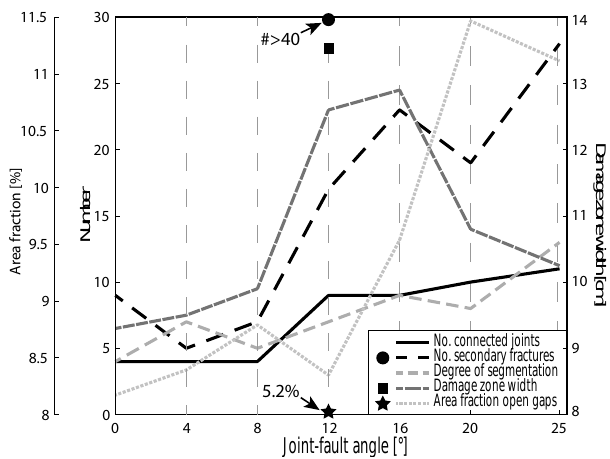
Figure 11. Results of the quantitative analysis. For definitions of the individual parameters please refer to Sect.